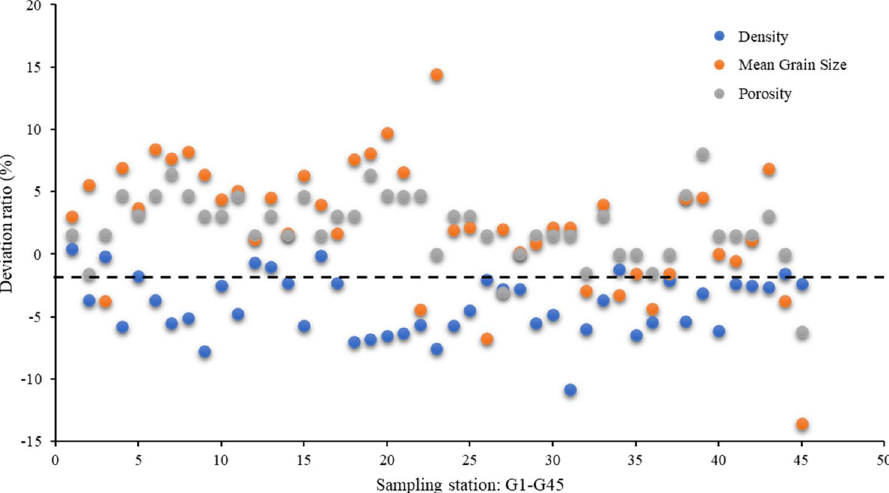
Figure 8. The deviation ratio of inversion results to sampling